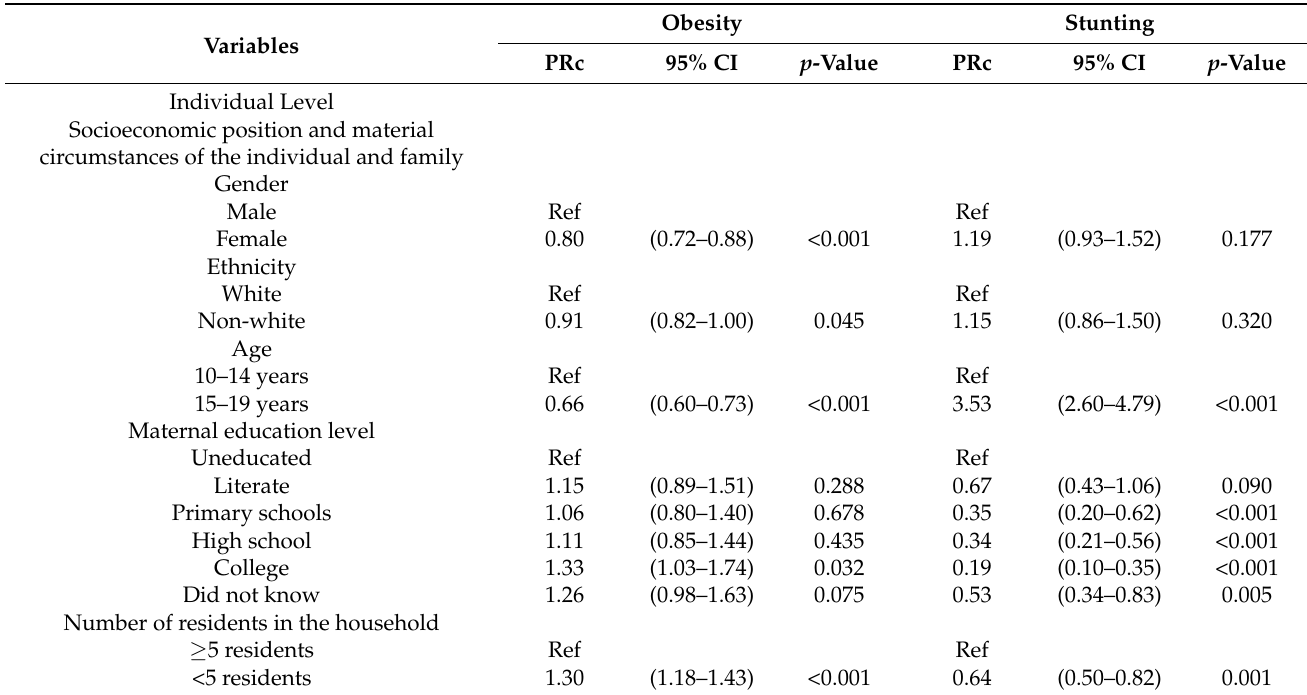
Table 2. Bivariate associations of obesity and stunting among Brazilian adolescents and individual and school level variables, National School Health Survey,